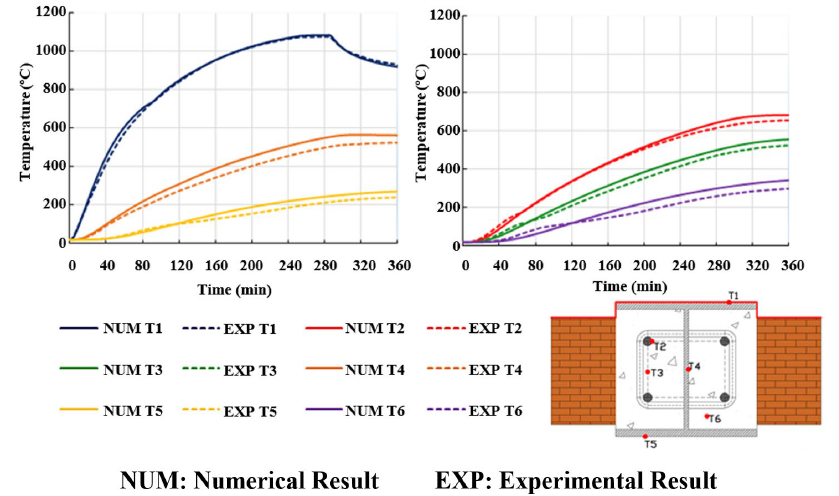
Figure 3. Comparison of numerical models and experimental results: